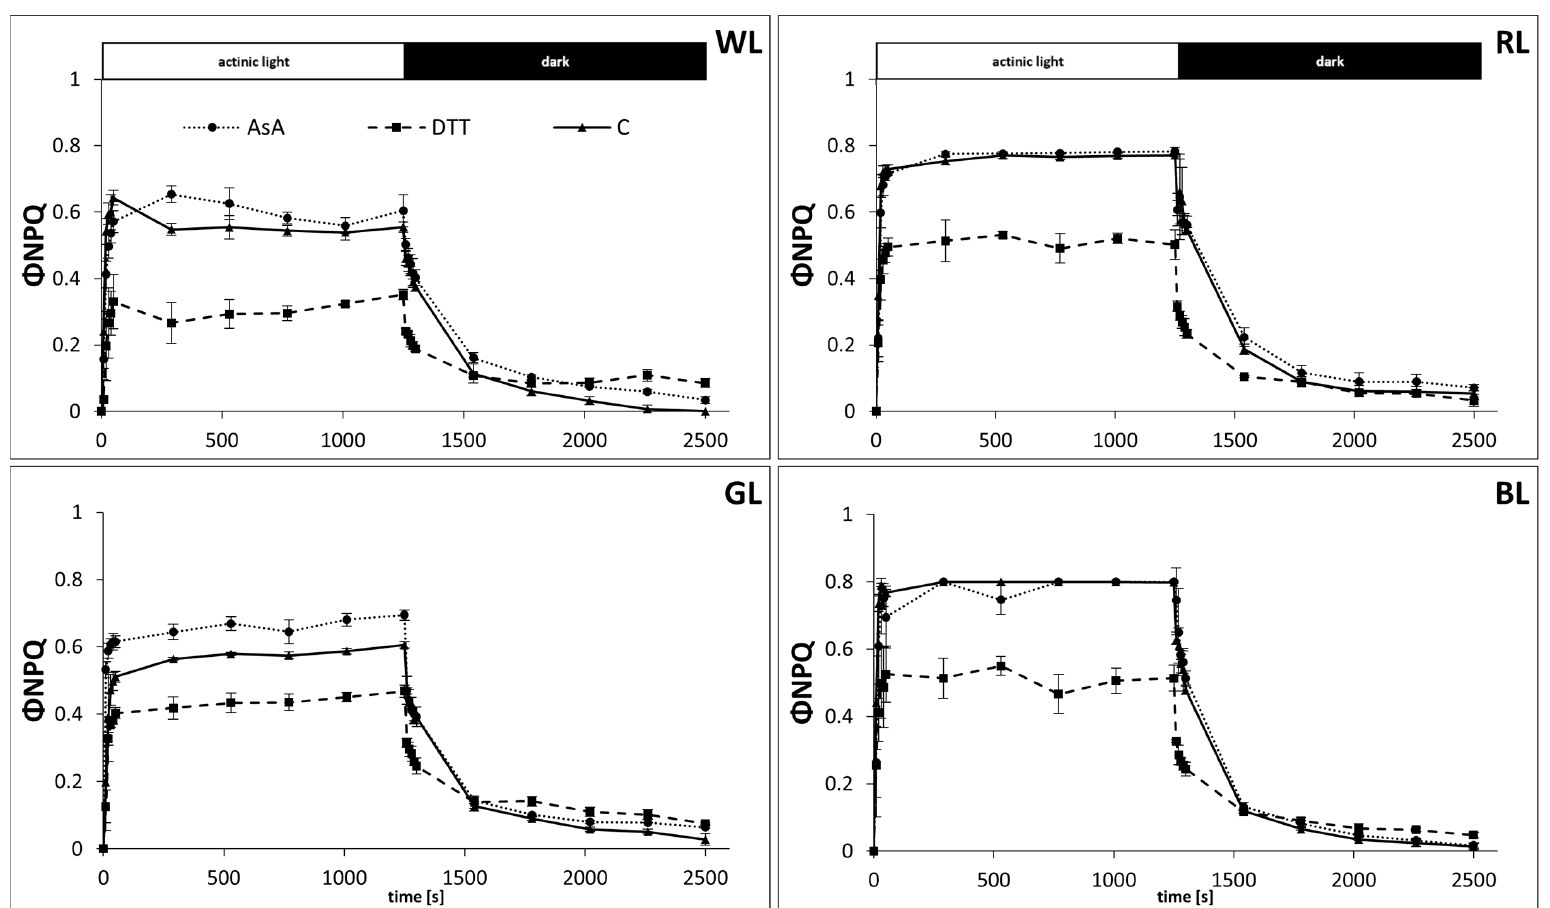
Figure 6. Measurement of the quantum yields of regulated energy dissipation, Φ NPQ, in leaves of tomato plants ( Solanum lycopersicum L. cv. Malinowy Ozarowski) grown under different light conditions (see Material and Methods for details). 10 mm diameter leaf discs were infiltrated with 10 mM ascorbic acid (AsA) or 5 mM dithiothreitol (DTT), or distilled water (C, control) for 30 min in the dark, followed by pre-illumination at 500 µ mol m − 2 s − 1 of RGB light for next 30 min. The dynamics of the Φ NPQ were determined in re-darkened leaf samples illuminated for 20 min at 185 µ mol m − 2 s − 1 of blue actinic light (AL = 450 nm) (induction), followed by 20 min of dark incubation (relaxation), and derived from the maximum fluorescence induced by saturation pulses (5000 µ mol m − 2 s − 1 , 0.8 s) at each of the measuring points ( Φ NPQ = 1 − Φ PSII − Φ NO). Each data point represents the average ± SD of six independent measurements ( n = 6).